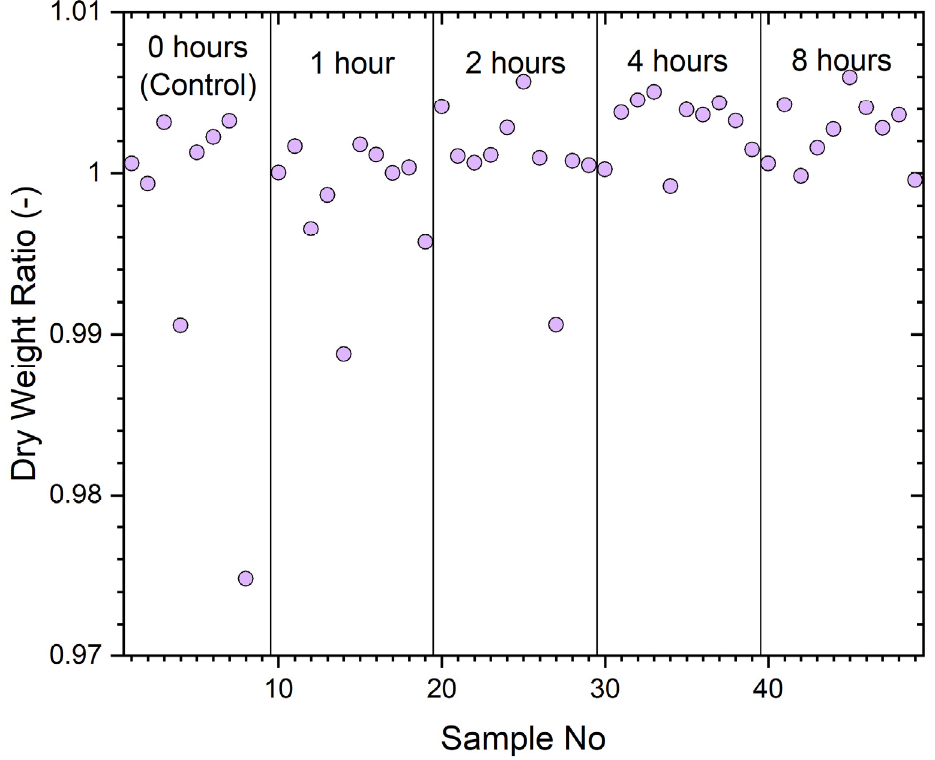
Figure 6. Dry weight ratio, worn/unworn of trial samples with wear times of 0, 1, 2, 4, or 8 h. The vertical lines delineate the period of wear. The typical ratio between 0.995 and 1.005 would be well inside the precision of the measurement technique as wool is very hydroscopic and samples rapidly gain moisture during weighing after they are removed from the desiccator. The results indicate that little dust (particulates) or nonvolatile human excretions are accumulated (less than ~50 mg) during the wear periods. The ratio of sample 8, a control sample, appears